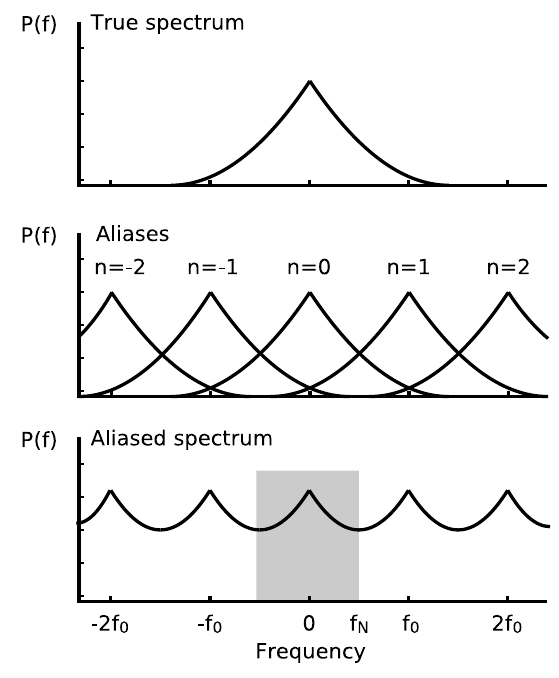
Fig. 2. Illustration of aliasing in the frequency domain. A true spectrum (top panel) appears periodically as aliases in the frequency domain with the frequency shift nf 0 (middle panel). This results in distortion of the original spectrum (bottom panel) even within the Nyquist frequency f N (shaded